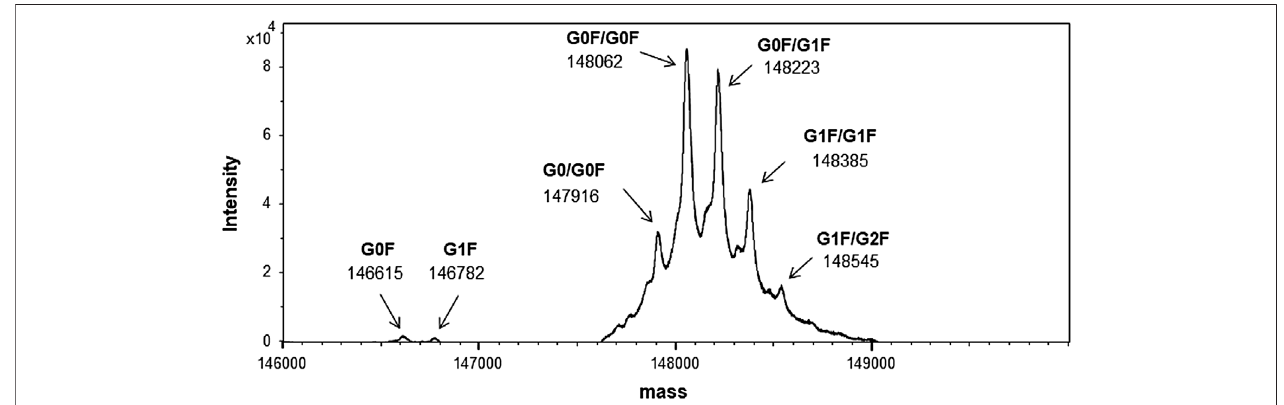
FIGURE4| Massspectrumofthecandidatereferencematerial(RM)(intactmassspectrometry).Peaksareshownasaveragedmass,andtheyareassignedbased on the glycoform. The calculated and observed masses are summarized in Supplementary Table S1